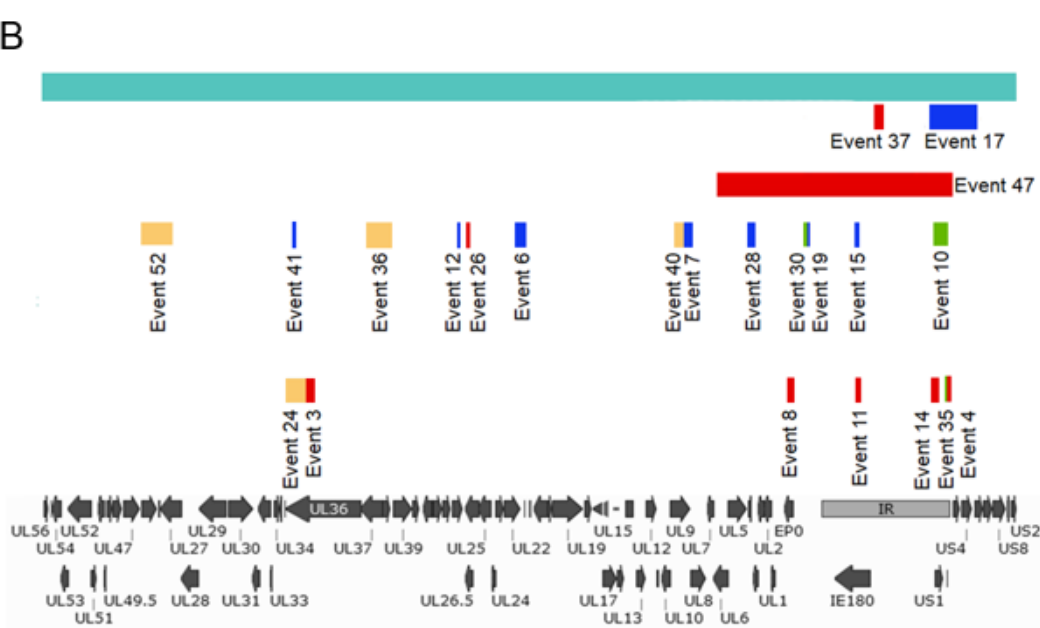
Figure 3. Recombination occurring pervasively in PRV newly sequenced strains. Recombination between PRV strains was determined by the Neighbor-Net split network and BootScan. ( A ) The Neighbor-Net split network was drawn by SplitsTree version 4.16 of 73 genomic sequences. The reticulate connections between each clade indicate events of recombination. Each clade was covered by a color scheme. The name of each strain is not displayed. ( B ) RDP analysis was applied to detect the recombination events in newly sequenced PRV genomes. All the recombination events are plotted in the schematic diagram. Each strip represents one recombination event and is labeled with one color. There are 4 colors in total, each representing different combinations of parental strains, as follows: red = Bartha-K61 + novel PRV variants; blue = Bartha-K61 + China classic strains, green = China classic strains + novel variants; yellow = novel variants + novel variants.